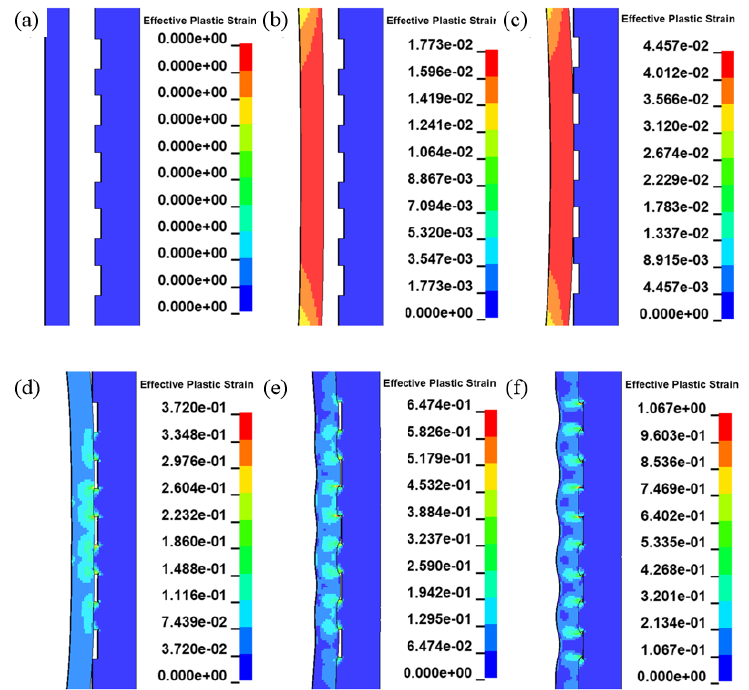
Figure 19. Forming process of pipeline joint with initial gap of 1 mm and discharge voltage of 6 kV.